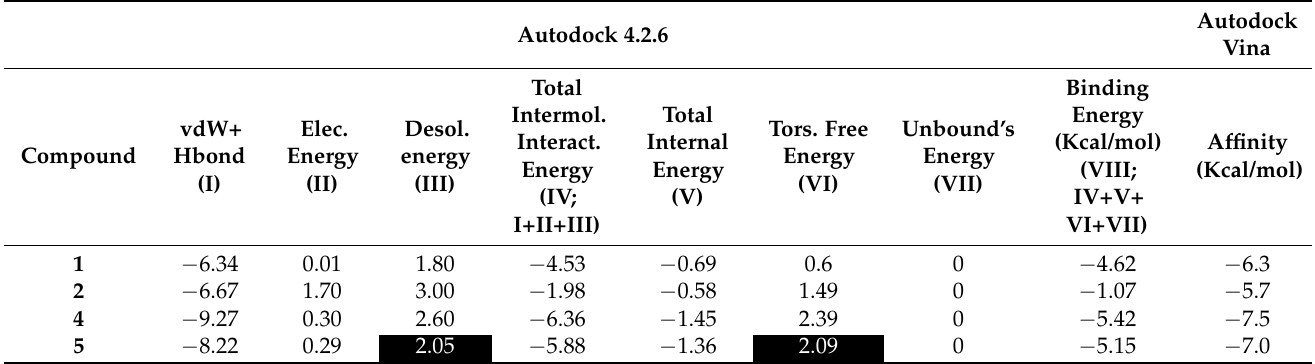
Table 3. Rescoring binding energy of the interested compounds ( 1 to 5 ) from Autodock 4.2.6 compared to Autodock